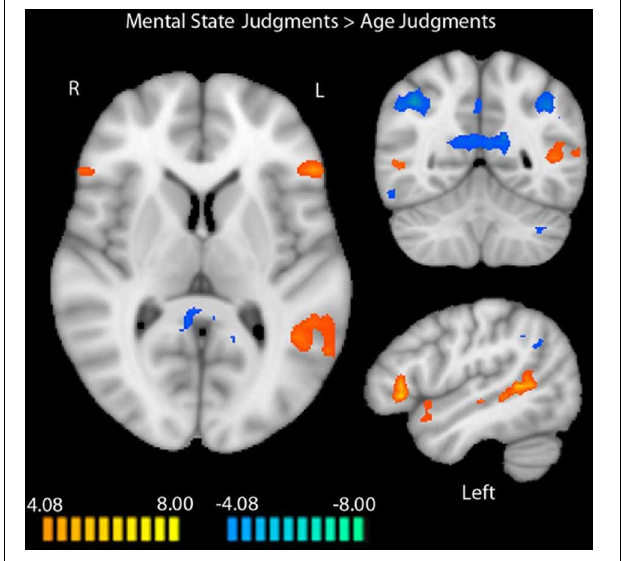
FIGURE 1 | Regions differentially activated by mental state and age judgments in the RMET-R administered with no previous stress induction. Regions in orange showed more activation to mental state judgments, while regions in blue showed more activation to age judgments (random-effects GLM, q < 0 . 05, k = 4). Data is interpolated to 1mm 3 resolution for